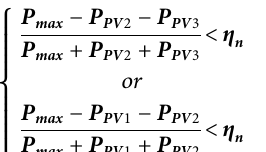
Frontiers in Energy Research |